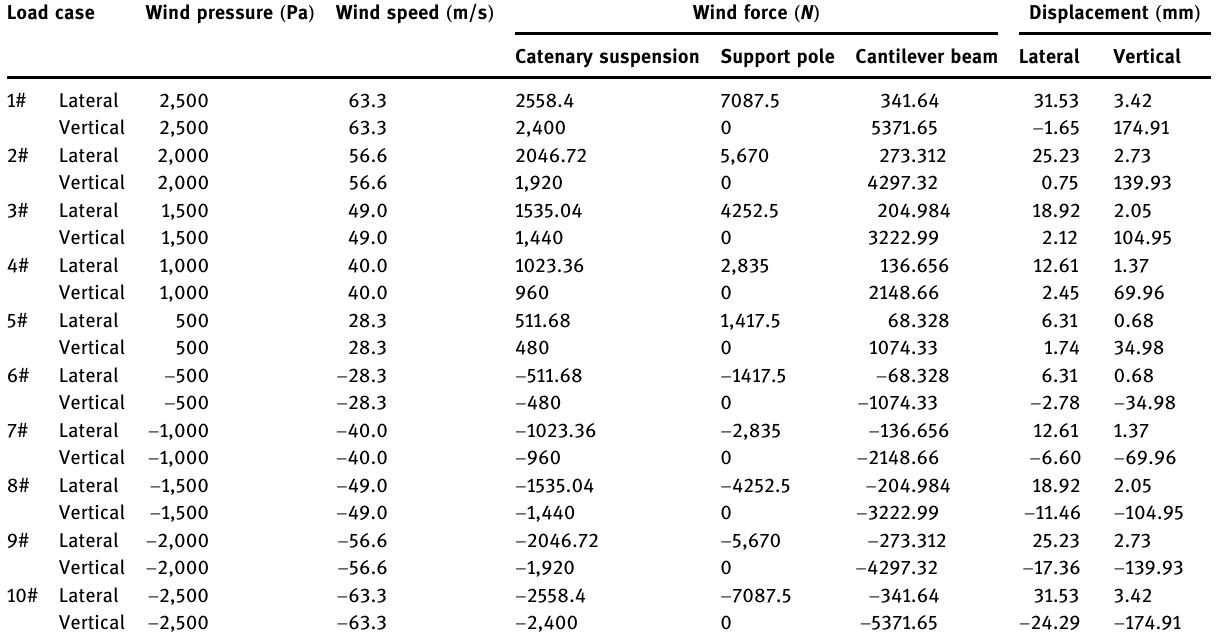
Table 2: Simulation results in lateral and vertical wind loading Wind pressure ( Pa ) Wind speed ( m/s ) Wind force ( N ) Displacement ( mm ) Load case